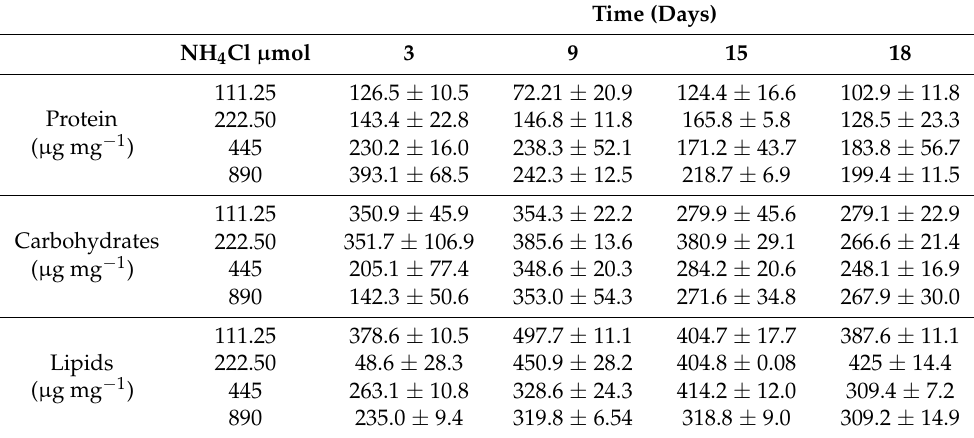
Table 4. Total protein, carbohydrate and lipid contents (mean value and standard deviation) of Thalassiosira weissflogii dry biomass at different days cultured at four different nitrogen concentrations of NH 4